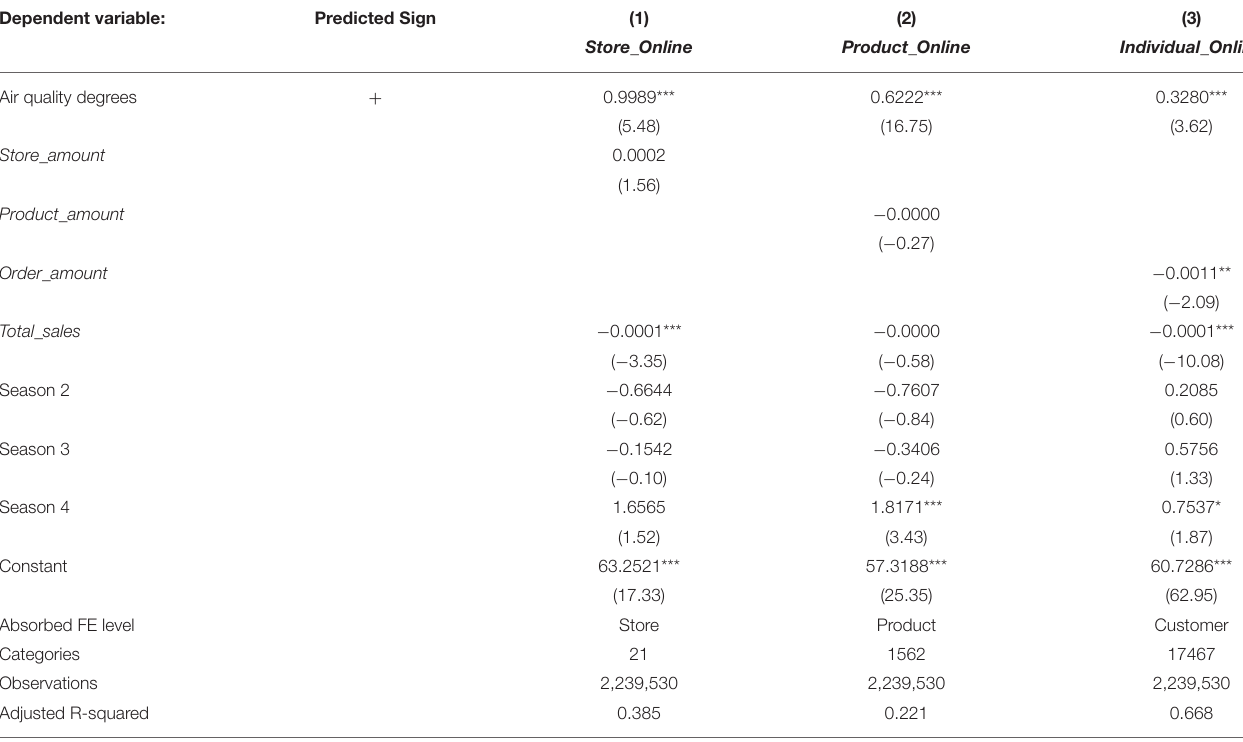
TABLE 9 | Main effect regression